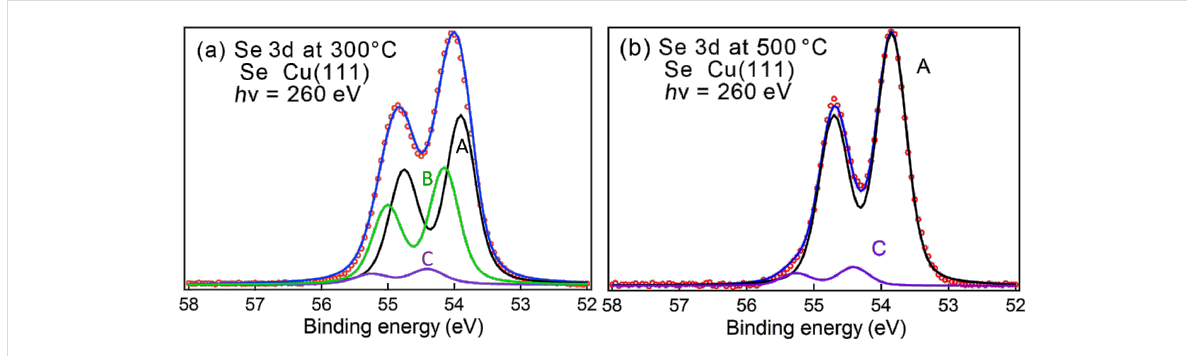
Figure 8: Se adsorption on Cu(111) from a Na 2 Se solution and after heating to the indicated